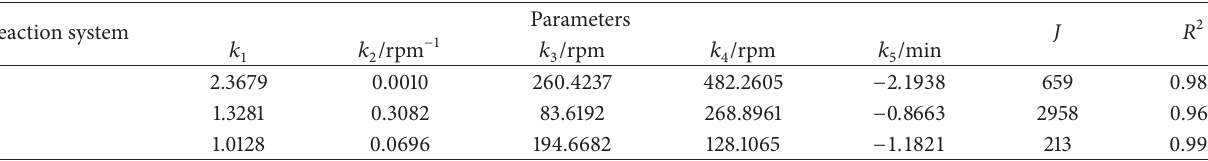
Table 3: Coefficients of the developed models and corresponding values of the objective function. Reaction system